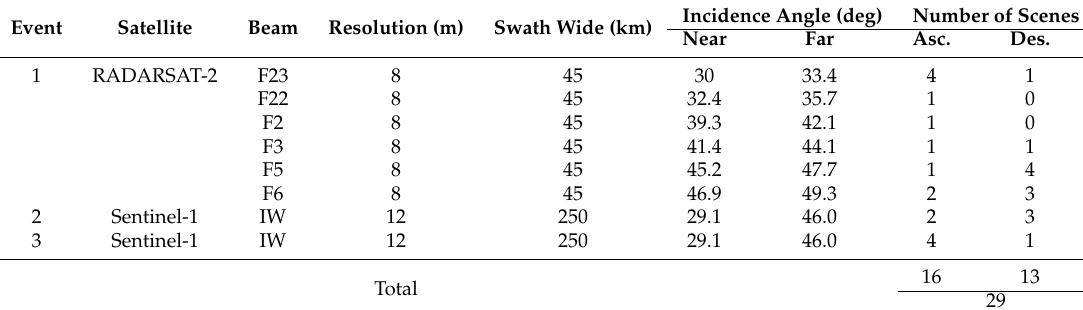
Table 1. Summary of the SAR data properties used in this